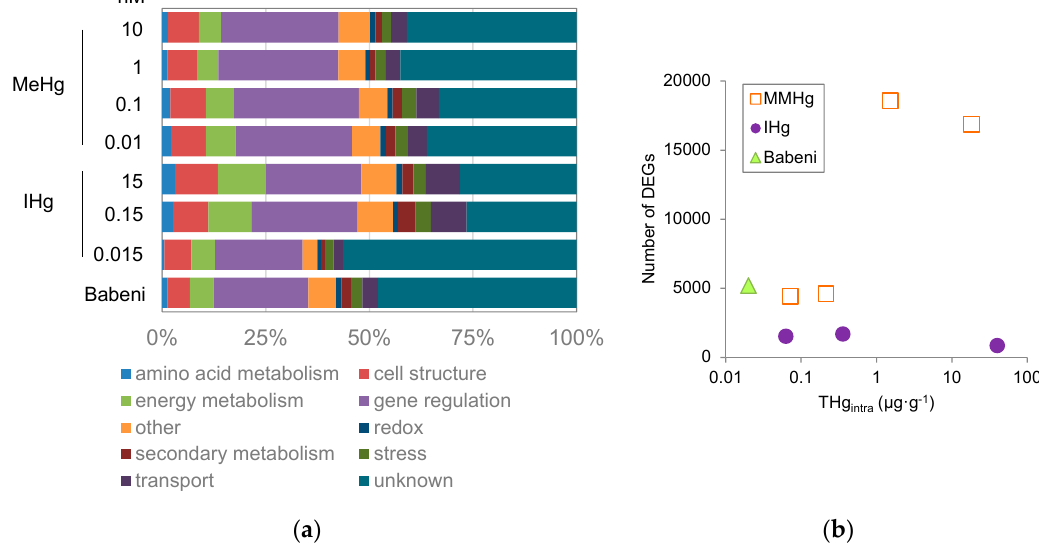
Figure 2. ( a ) proportion of regulated genes among gene ontology terms (Mapman terminology) and ( b ) number of deregulated genes (DEGs) as a function of THg bioaccumulated in the intracellularly in E. nuttallii exposed for 2 h with IHg, MMHg in the laboratory or in the Babeni Reservoir (Romania) [10,25].